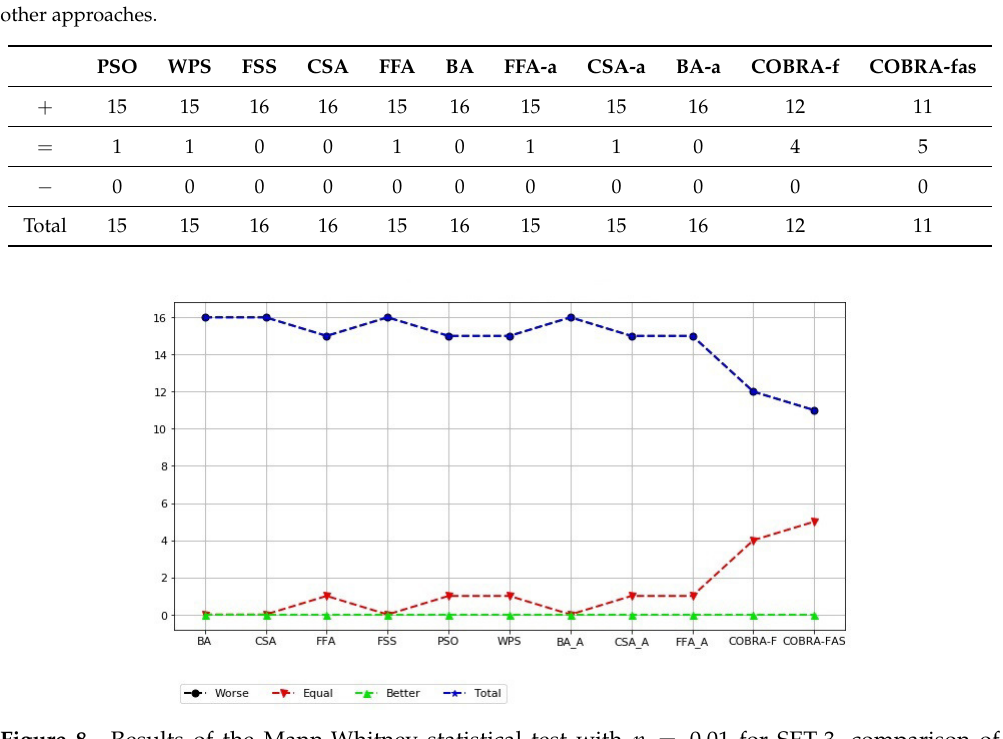
Figure 8. Results of the Mann-Whitney statistical test with p = 0.01 for SET-3, comparison of COBRA-SHA with other